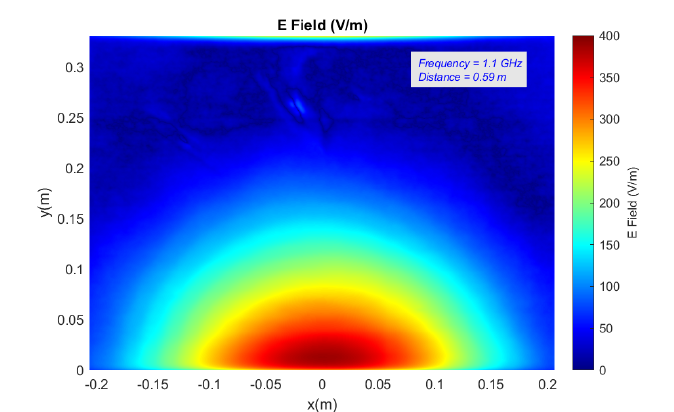
FIGURE 11. EMIR electric field measured at a distance of X=59 cm from the